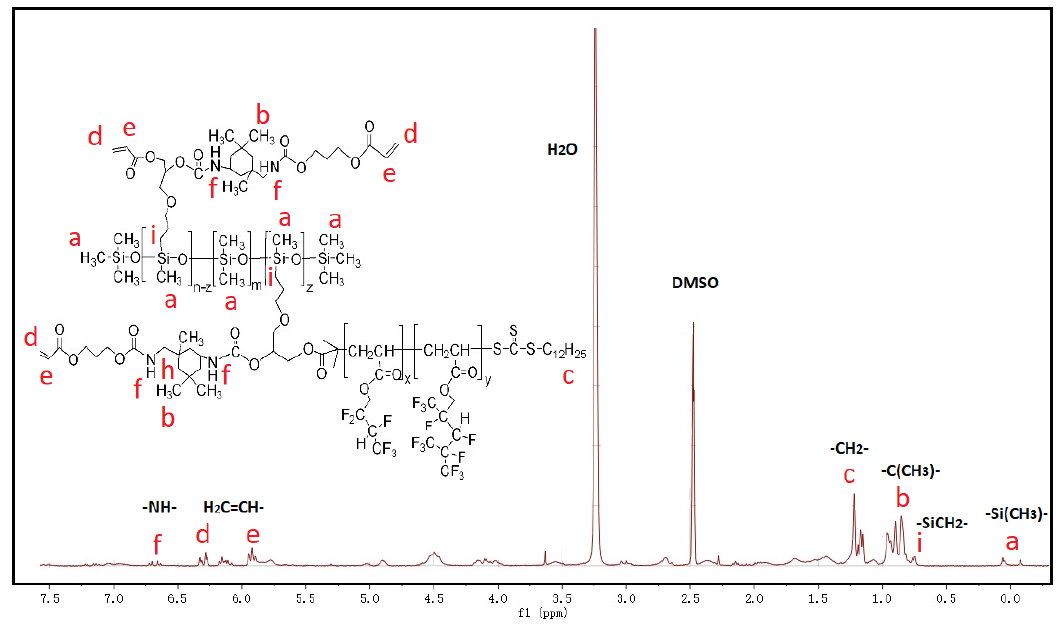
Figure 3. 1 H-NMR spectra of the fluorinated siloxane copolymer G-SP-(G01 + G05).